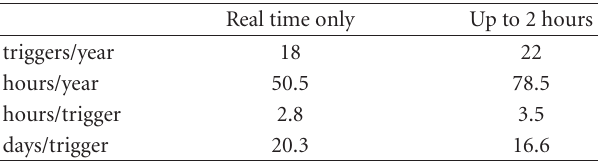
Table 2: Results of the GRB-planning